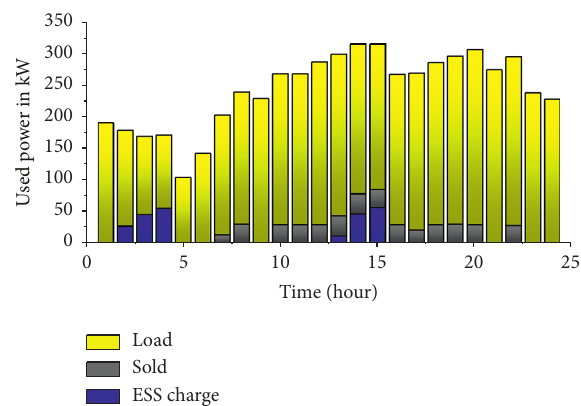
Figure 16: The optimum power consumption in the MG (con- sidering the load uncertainty).